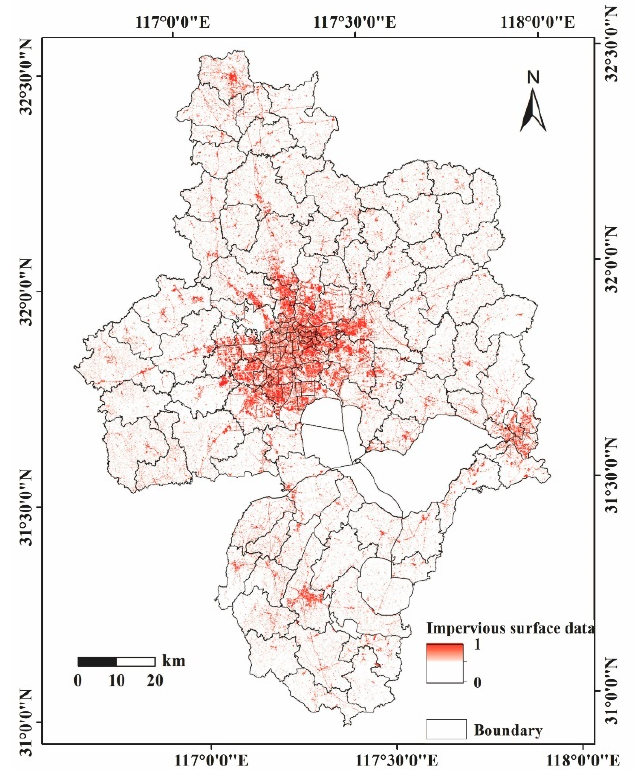
Figure 3. IS Distribution in Hefei. IS fraction values greater than 0.5 are calculated as impervious surfaces [27]. The deeper the colour, the greater is the value.